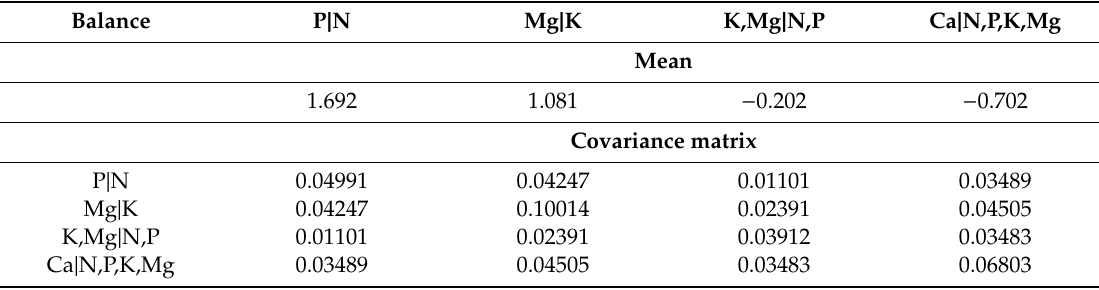
Table 7. Covariance matrix and means of isometric log ratios (balances) of 181 nutritionally balanced specimens of peach trees in Rio Grande do Sul,